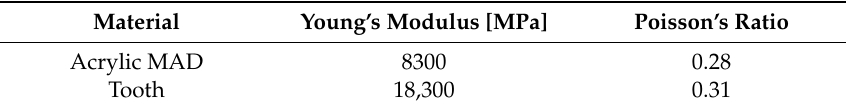
Table 1. Material properties used in the finite element model.